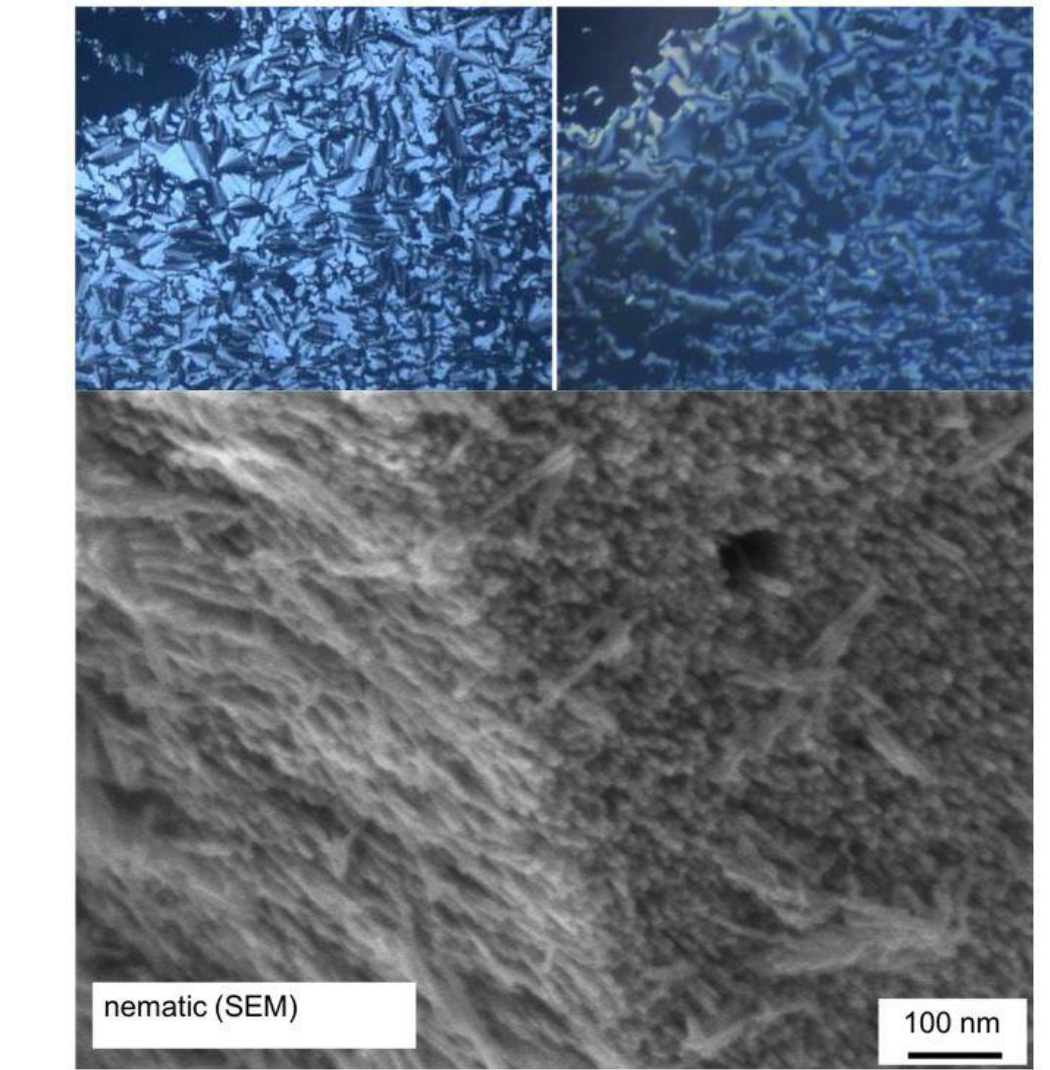
Figure 6. Liquid crystalline phases formed from shape anisotropic inorganic nanoparticles in highly concentrated solution [20]; ( a ) polarizing microscopy showing smectic and nematic textures with increasing temperature. ( b ) SEM microscopy of the dried phase consisting of TiO 2 nano-rods; reproduced with permission of [20], published by Wiley-VCH, 2007.